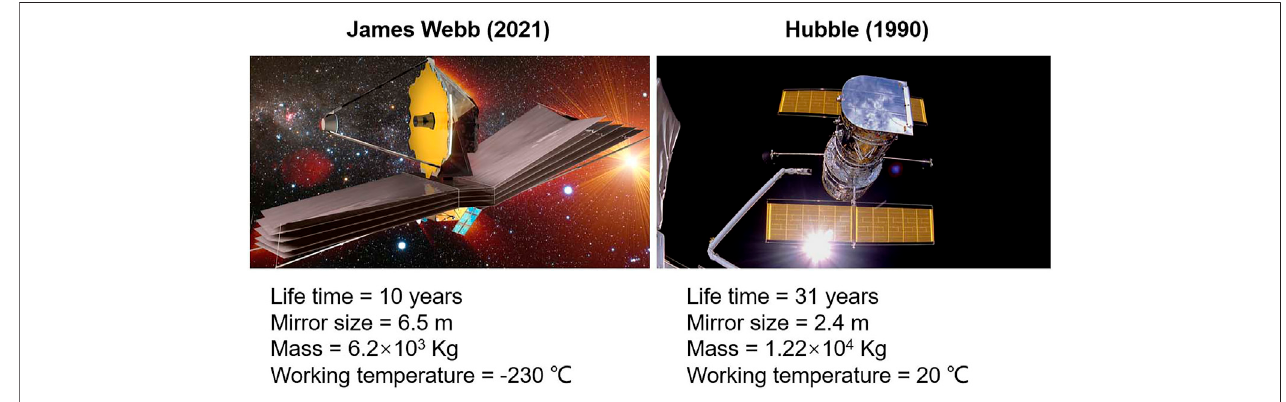
FIGURE 1 | Comparative ef fi cacy of James Webb